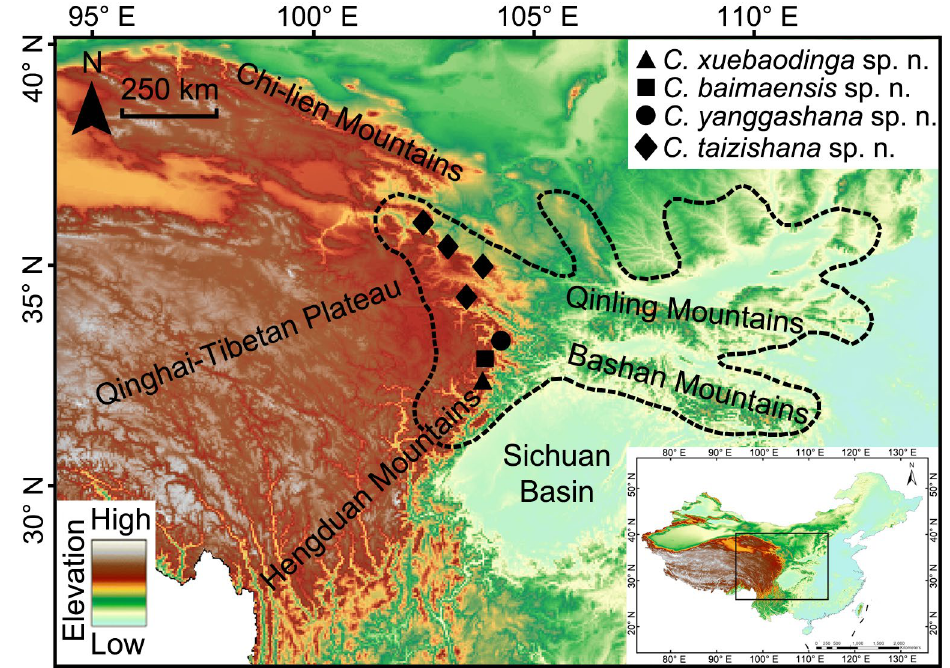
Fig. 2. Species distribution range of the genus Cerapanorpa Gao, Ma & Hua, 2016 and localities of new species. The limit shown is an approximation defined by collecting localities for specimens of Cerapanorpa . Triangle, C. xuebaodinga sp. nov. Square, C. baimaensis sp. nov. Circle, C. yanggashana sp. nov. Diamond, C. taizishana sp.